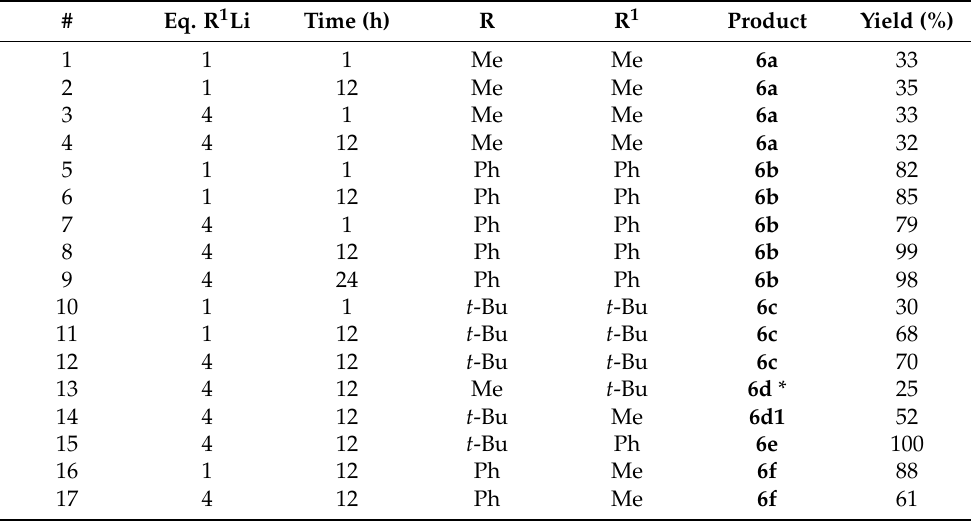
Table 3. Reaction conditions and yields of carbinols 6a–f and phenol 6d1 .